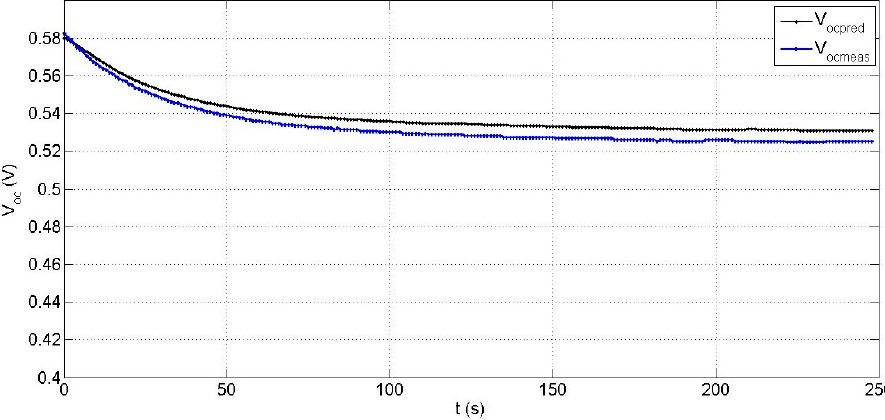
Figure 3. Predicted T b,pred (t) and measured T b,meas (t) profiles of a c-Si bare cell in controlled laboratory conditions.